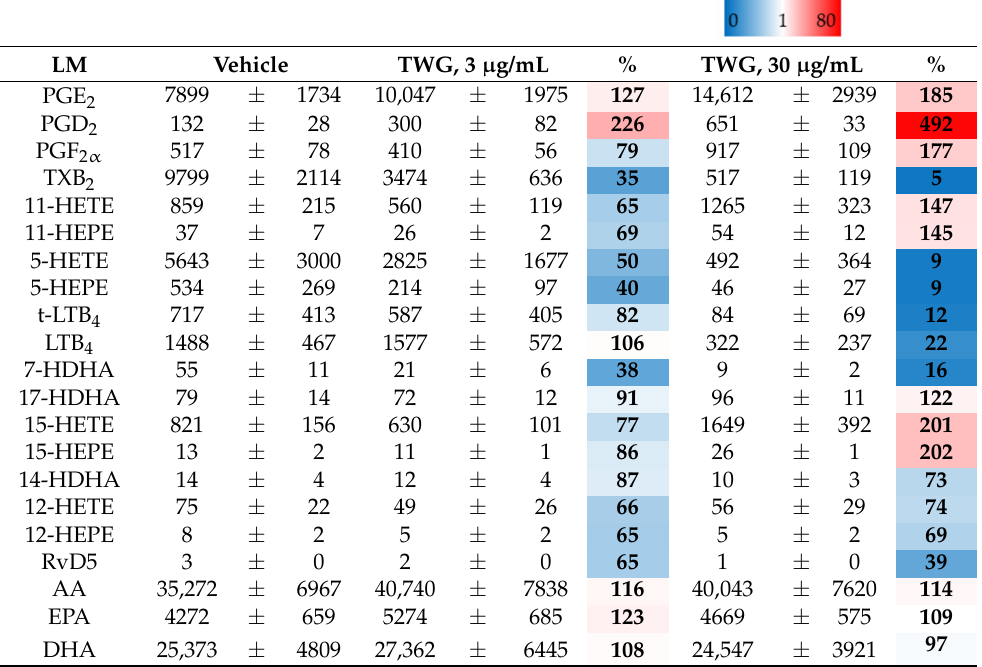
Table 1. Heatmap of LM produced by pro-inflammatory human M1-MDM and effects of Table 1 . MDM were pre-treated for 15 min with 3 or 30 µ g/mL TWG or 0.1% DMSO as vehicle. Then, cells were stimulated with 1% S. aureus -conditioned medium (SACM) for 90 min. LM were analyzed by UPLC-MS/MS in the supernatants of cells. Data are means ± S.E.M., n =